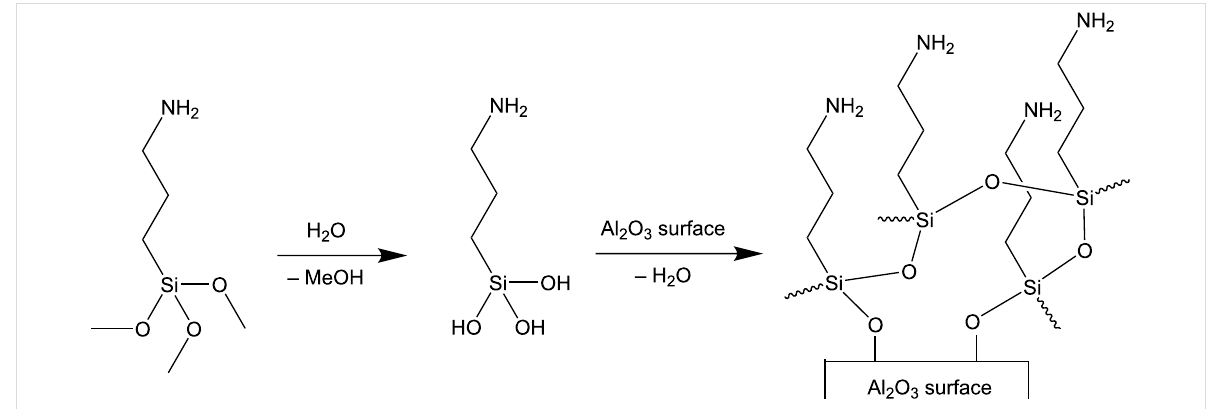
Figure 1: Hydrolysis of methoxy groups and functionalization of the surface of the ALOX-membrane due a condensation reaction between hydroxyl groups on the surface and hydroxylated silanes.